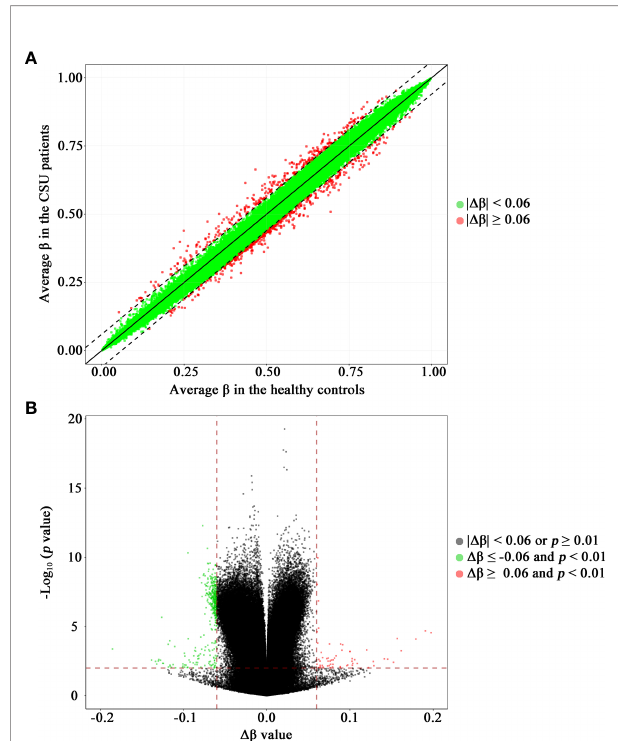
FIGURE 2 | Scatter plot and volcano plot of the 832,347 CpG sites between the CSU patients and the healthy controls. (A) Scatter plot. This scatter plot indicates the overall correlation of the average methylation levels between the CSU patients and the healthy controls. The ordinate and abscissa represent the average b value for each CpG site of the 95 CSU patients and the 95 healthy controls, respectively. A CpG site with | D b | < 0.06 and a CpG site with | D b | ≥ 0.06 is signed by a green circle and a red circle, respectively. (B) Volcano plot. The ordinate represents the p -value ( − log10 scale) for each CpG site and the abscissa represents the D b value of each CpG site. Thresholds are shown as dashed lines. The vertical red dashed lines represent 6% change in D b values. The horizontal red dashed line represents the signi fi cant cutoff of p = 0.01. A gray circle represents a CpG site with | D b | < 0.06 or p ≥ 0.01. A green circle represents a hypomethylated differentially methylated position (DMP) with D b ≤ − 0.06 and p < 0.01. A red circle represents a hypermethylated DMP with D b ≥ 0.06 and p < 0.01. CSU, chronic spontaneous